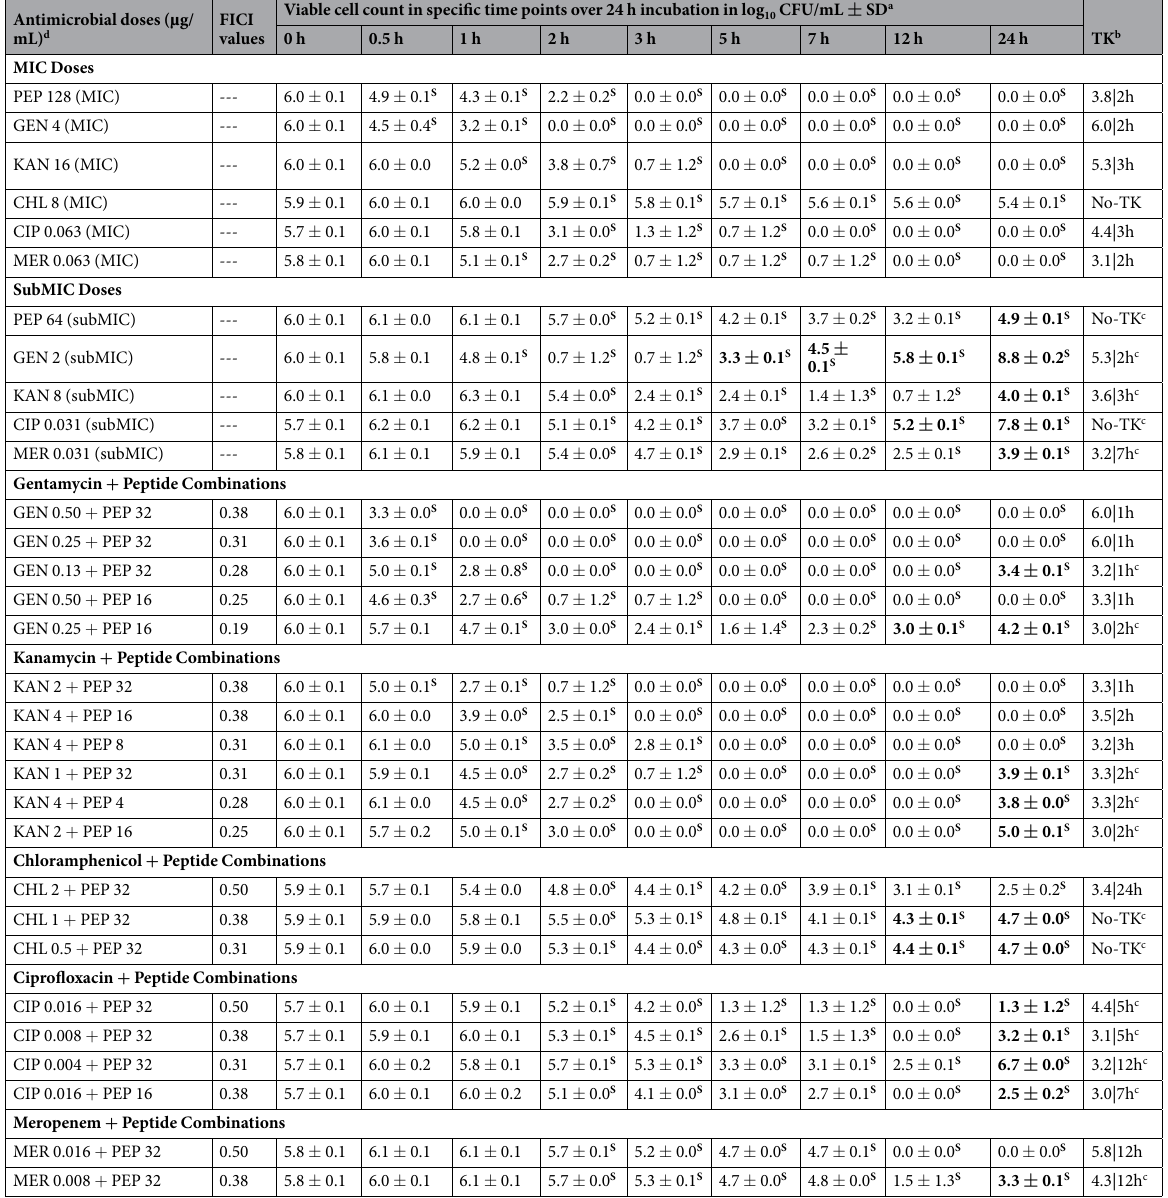
Table 3. Kinetics of STEC 86–24 killing using peptide, antibiotics and synergistic combinations. Data are expressed as means ± standard deviation. All assays were carried out in triplicate and on at least two different occasions. a Evaluation of time-kill assay in bacterial cultures treated with peptide, antibiotic and synergistic combinations. Data are expressed in log 10 CFU/mL as means ± standard deviations of two independent experiments in triplicate. S One-way ANOVA and Tukey’s test were used to determine means statistically significant compared to the no-antimicrobial control (p < 0.05). b TK (Time-kill) = log decrease|bactericidal effect hr (at least 3-log 10 reduction in the original inoculum according CLSI guidelines, M26-A, vol. 19). c Signs of bacterial recovery from subMIC treatments and the lowest FICI values (data are shown in bold). d PEP, peptide; GEN, gentamicin; KAN, kanamycin; CHL, chloramphenicol; CIP, ciprofloxacin; MER,